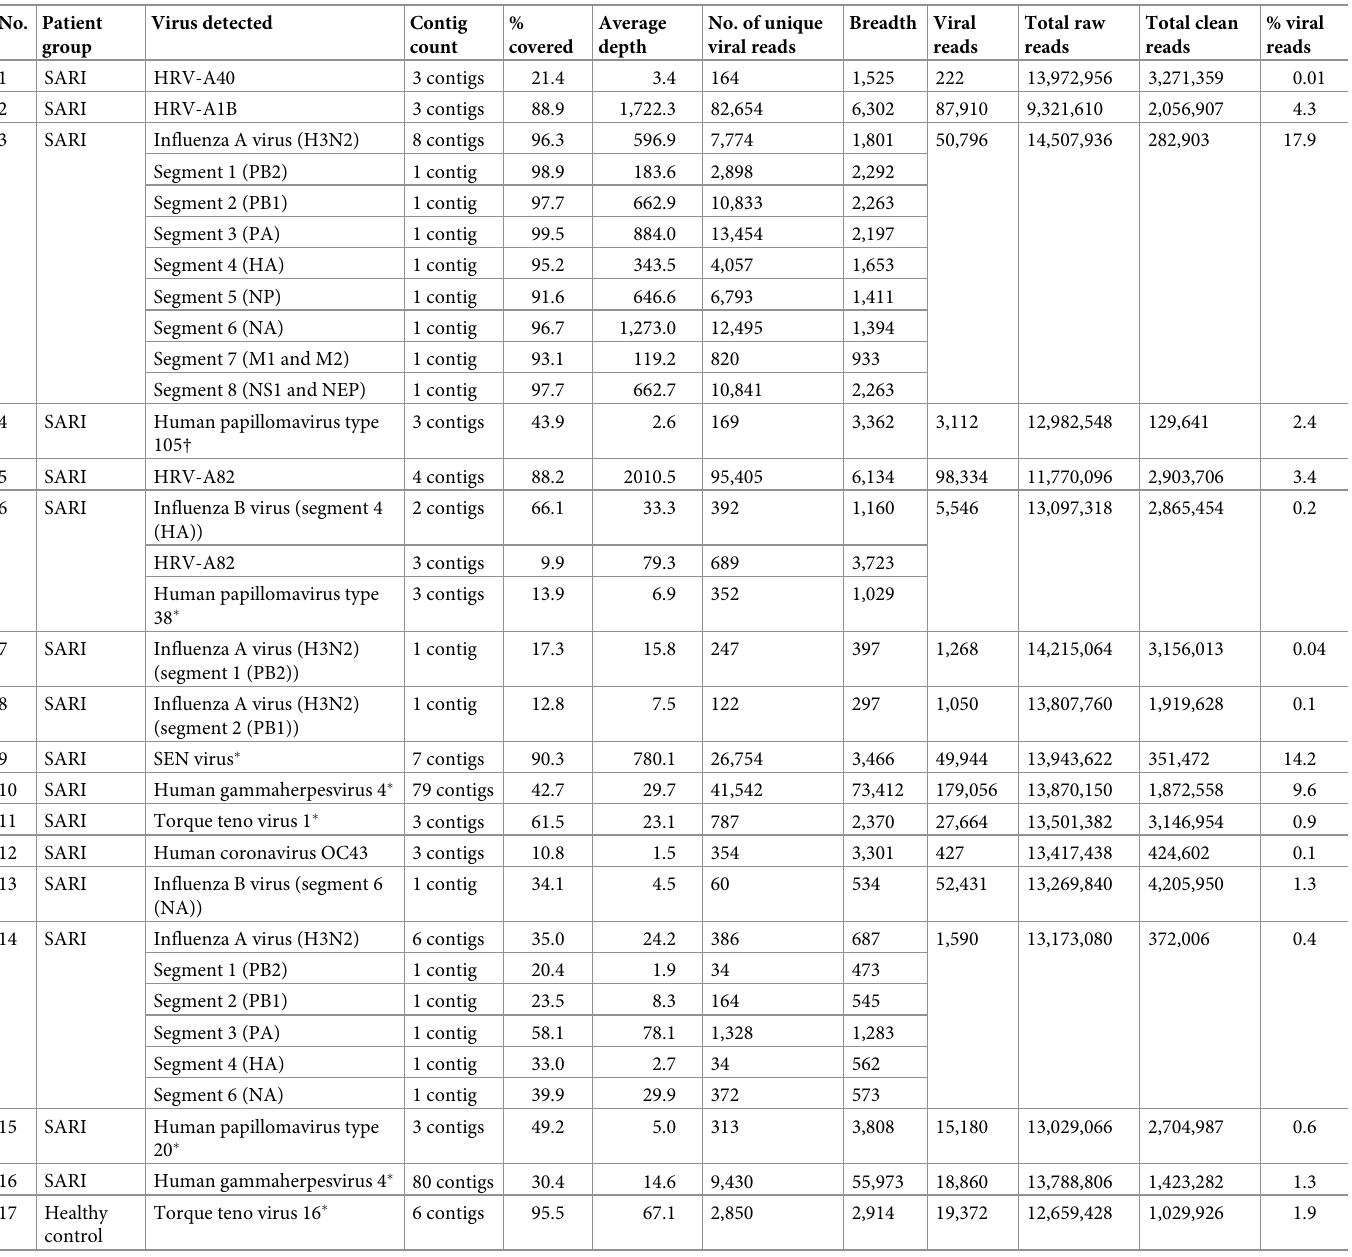
Table 3. Human viruses detected by viral metagenomics